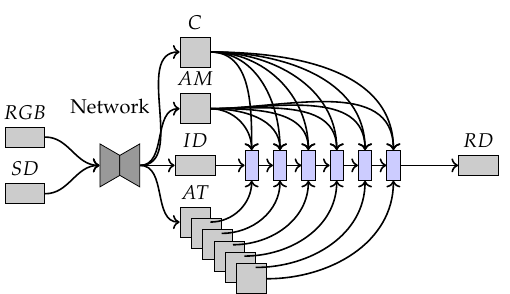
Figure 10. The inputs shown on the left are the RGB image and the sparse depth captured by the LiDAR sensor. The encoder–decoder network outputs the confidence shown as C , the affinity matrix as AM , the initial depth prediction as ID and the attention maps as AT . The initial depth is refined over 6 steps of the DySPN, shown in blue, to obtain the final refined depth map shown as RD .